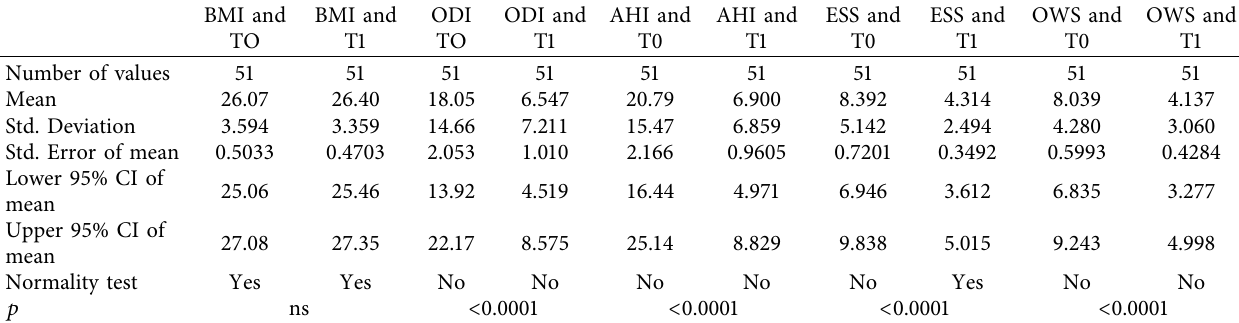
Table 1: Data and statistical analysis of the extracted records.